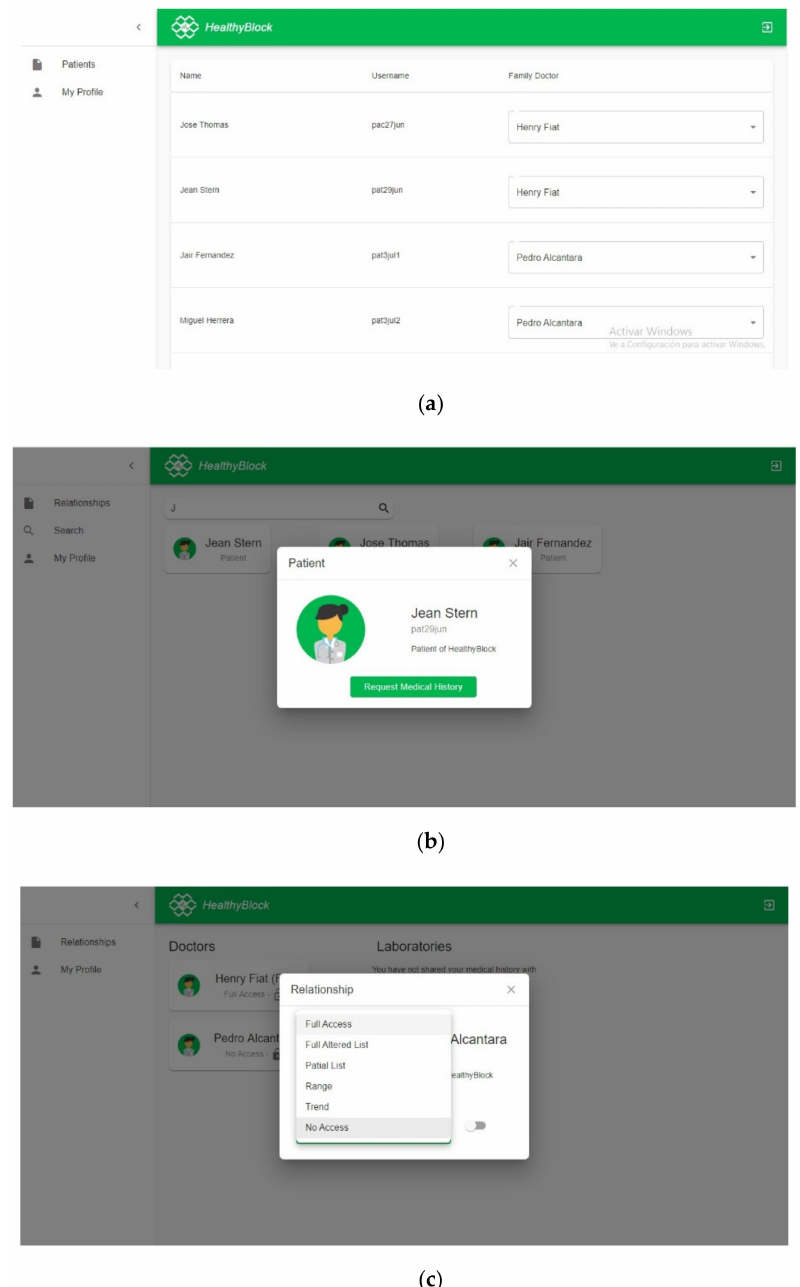
Figure A2. Prototype permit processes: ( a ) Manager associates family doctor with a patient; ( b ) Doctors can request access; ( c ) Patient can grant access to a medical